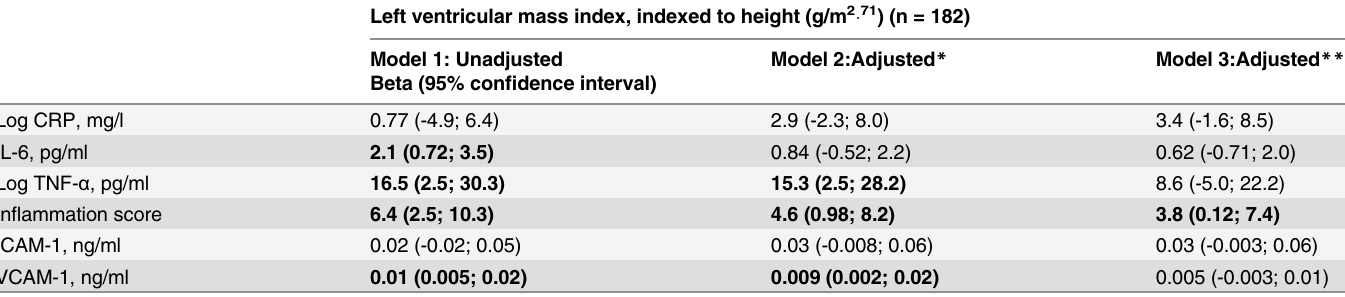
Table 2. The association between both inflammation markers and endothelial dysfunction markers with left ventricular mass using linear regres- sion analysis in cross sectional